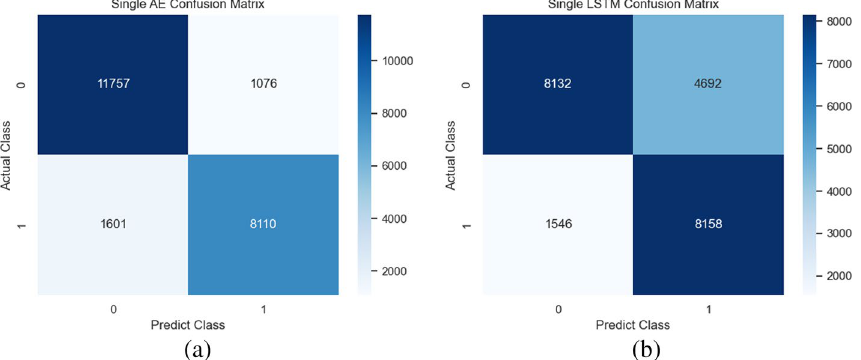
Fig. 9 Mixing matrix for NADLA model classification